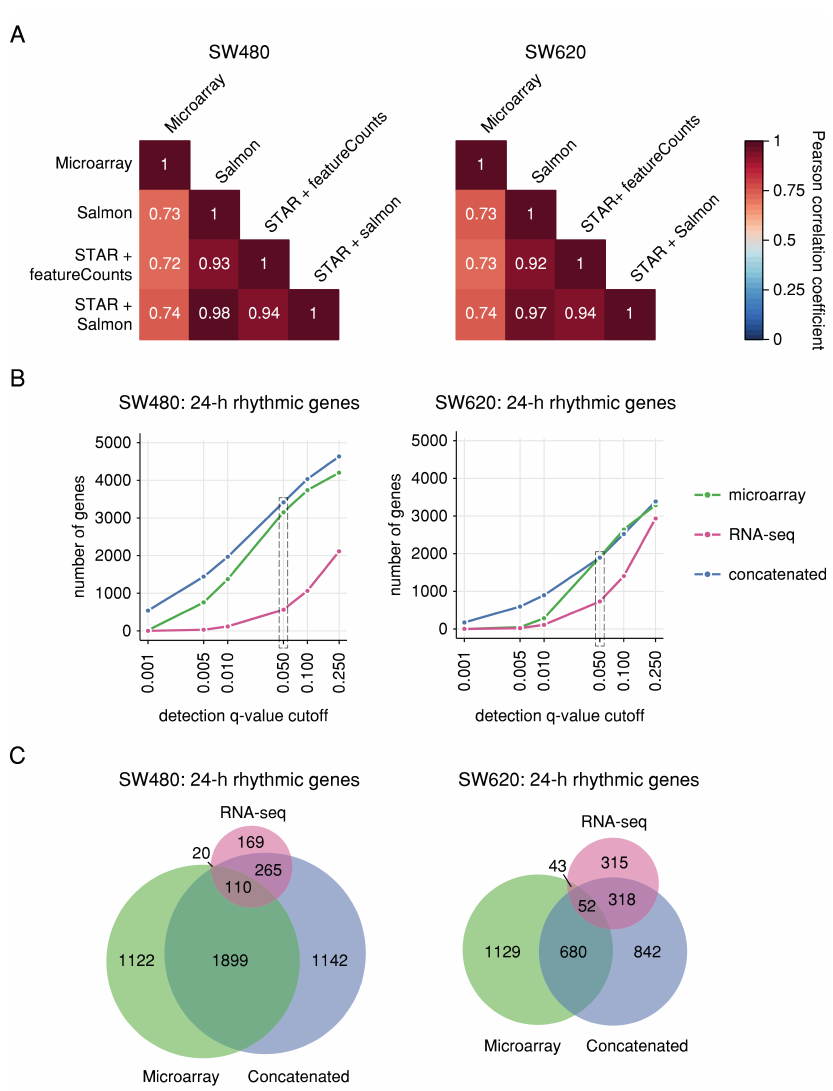
Figure 2. Correlation of gene expression and intersection of 24 h rhythmic gene sets between circadian microarray and RNA-seq data of human CRC cell lines. ( A ) Mean Pearson correlation coe ffi cients between expression values determined by di ff erent platforms and di ff erent downstream methods for SW480 cells (left panel) and SW620 cells (right panel). Expression values were determined based on microarray data and RNA-seq data ( Salmon , STAR + featureCounts , STAR + Salmon ). Shown are the mean Pearson correlation coe ffi cients between gene expression values determined for identical time points (12–24 h since synchronization). ( B ) Number of 24 h rhythmic genes for SW480 cells (left panel) and SW620 cells (right panel) based on the three datasets (microarray: green; RNA-seq: pink; concatenated: blue) as determined by harmonic regression for di ff erent q-value cut-o ff and a relative amplitude cut-o ff of 0.1. The grey rectangle marks the cut-o ff chosen to determine 24 h rhythmic gene for subsequent analyses. ( C ) Intersections between 24 h rhythmic gene sets in SW480 cells (left panel) and SW620 cells (right panel) identified based on microarray data (green), RNA-seq data (pink) and the concatenated expression of both methods